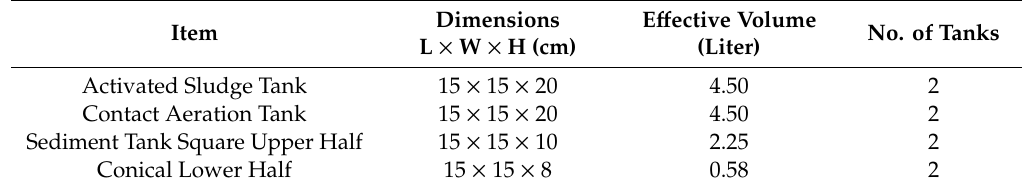
Table 5. Size and e ff ective volume of each tank in small model